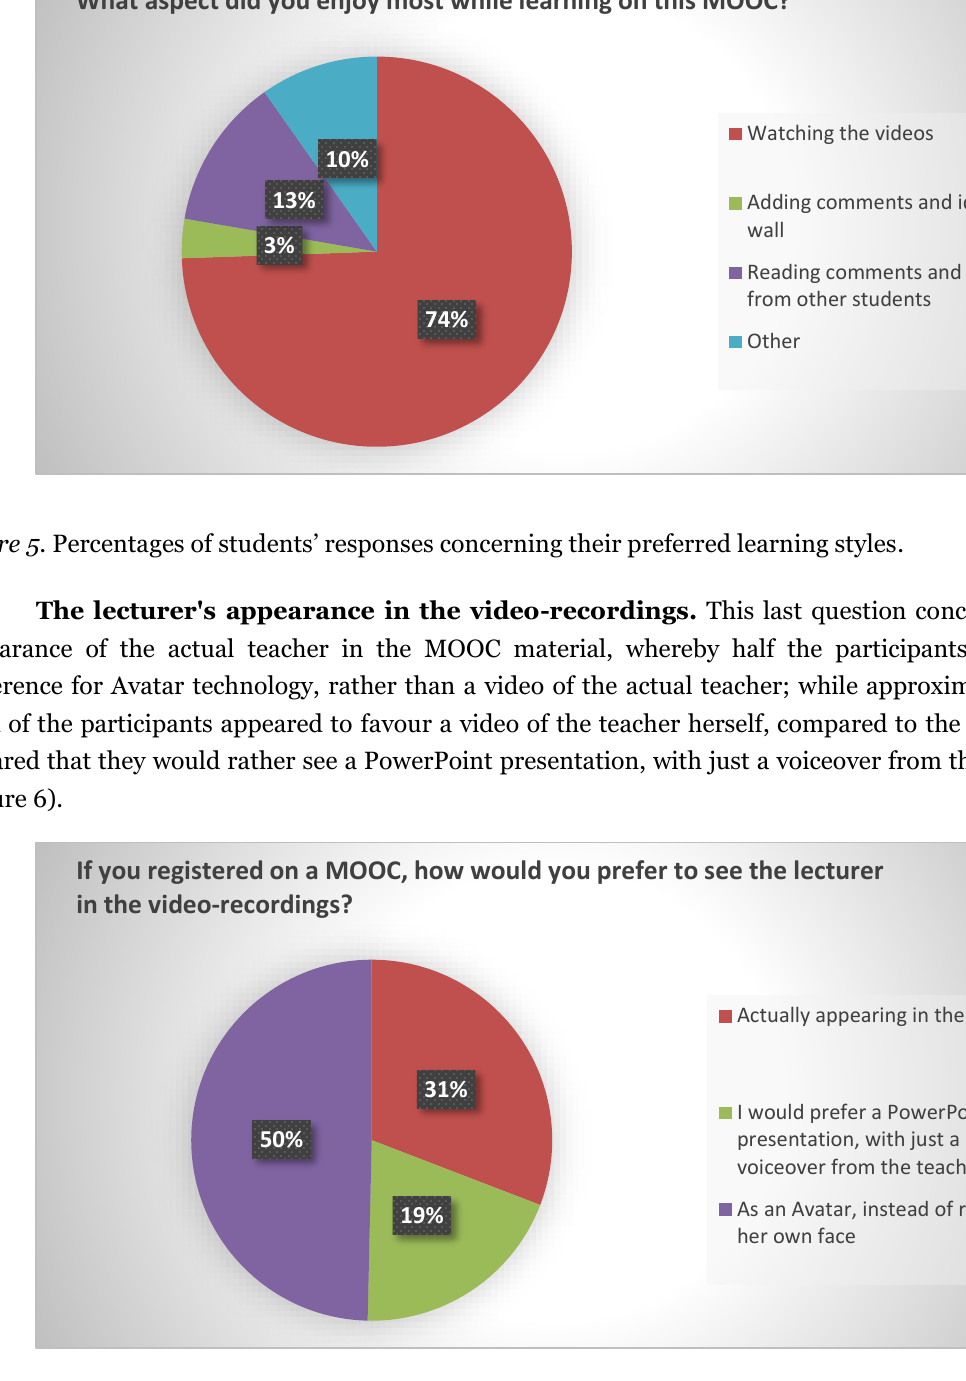
Figure 6. Percentages of students’ responses to the lecturer’s appearance in